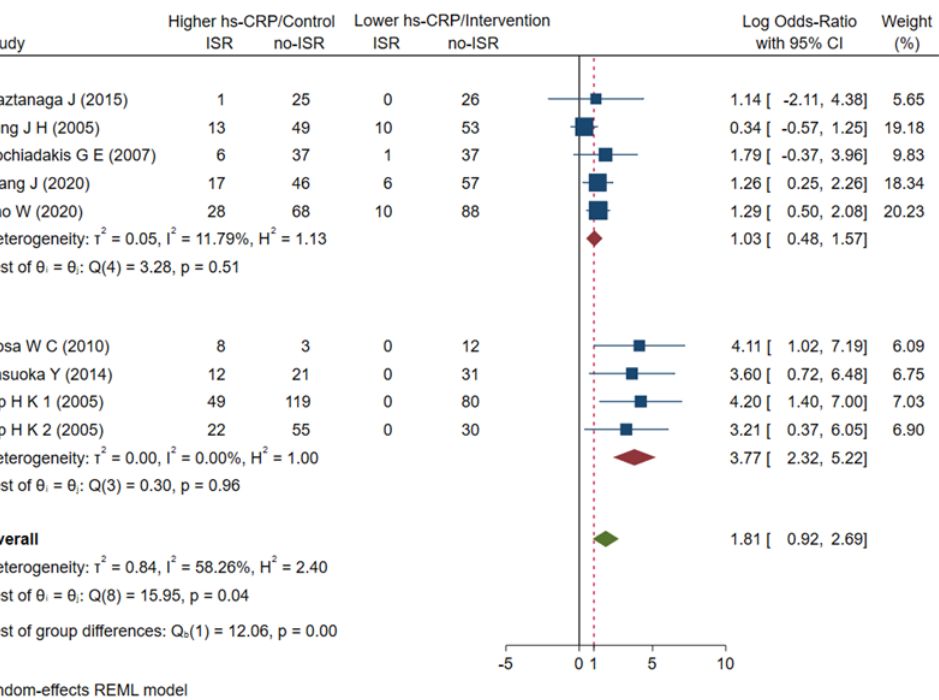
Figure 7. Meta-analysis of ORs in studies evaluating prognostic value of hs-CRP to restenosis in higher vs lower hs-CRP group as sub-grouped by diabetes. OR: odds ratio, hs-CRP: high-sensitive C-reactive protein, ISR: in-stent restenosis, 0: without diabetes 1: complicated with diabetes [21–29].